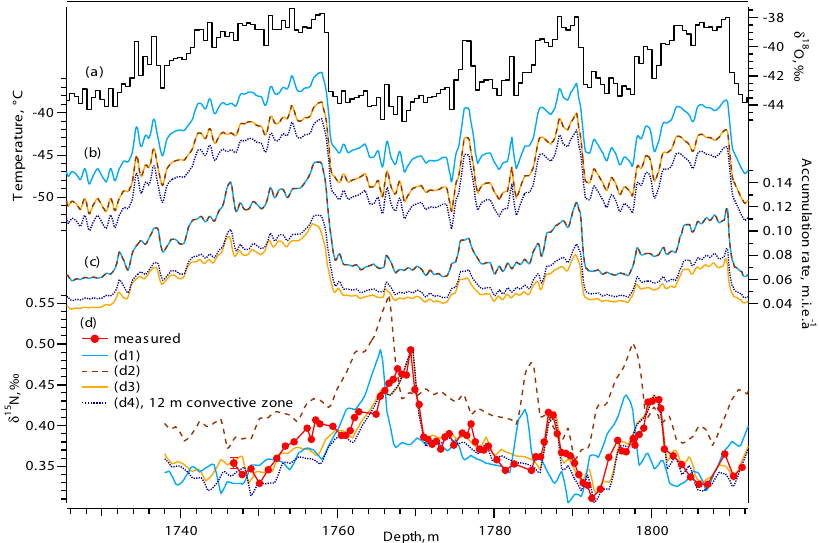
Fig. 3. Measured and modeled δ 15 N for NEEM on DO 8 to 10, plotted on a depth scale. (a) δ 18 O ice ‰, this study. (b) Temperature scenarios and (c) accumulation scenarios used to produce the δ 15 N reconstructions in (d) plotted on the same color. Red dots: measured δ 15 N data. (d1) to (d4) Modeled δ 15 N. (d1) to (d3) using a 2m convective zone. (d4) using a 12m convective